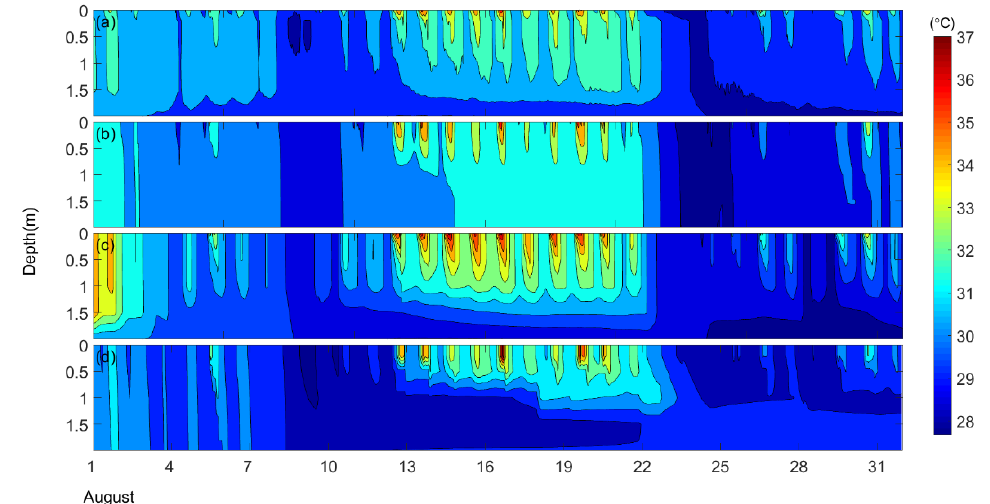
Figure 4. Simulation of vertical temperature profile (lake stratification) in the August 2012 at BFG station in Lake Taihu ( a ) Observations, ( b ) CLM4-LISSS, ( c ) E- ε, ( d )LAKE.